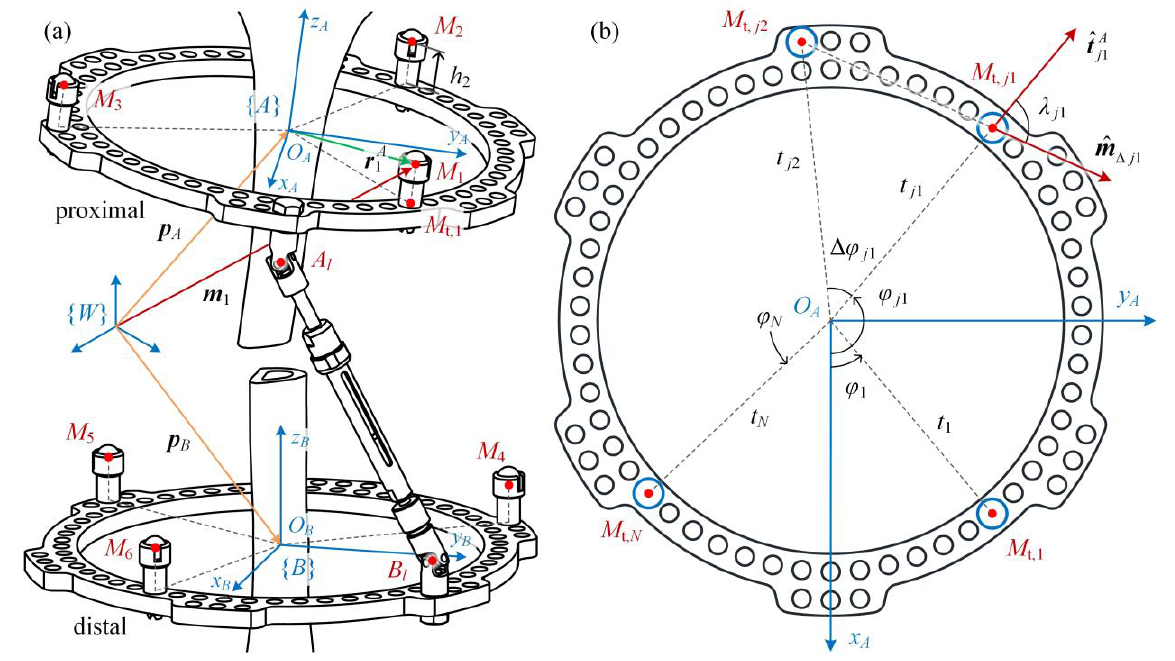
Figure 3. ( a ) Schematic of the mechanism and image markers. ( b ) Projection of the marker centers xy -plane.